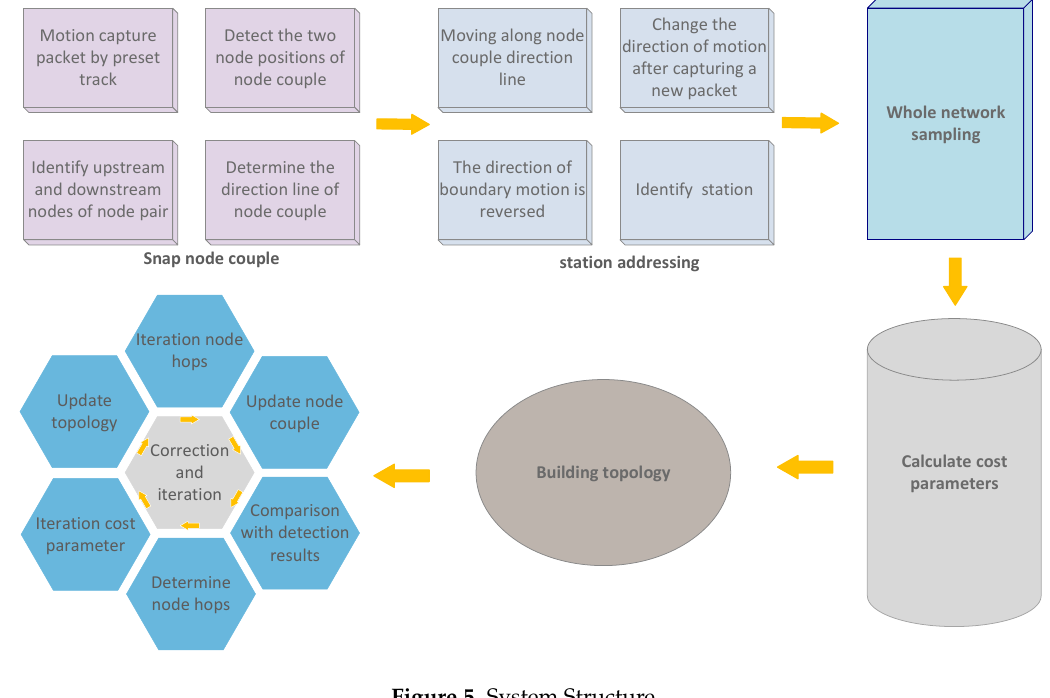
Figure 5. System